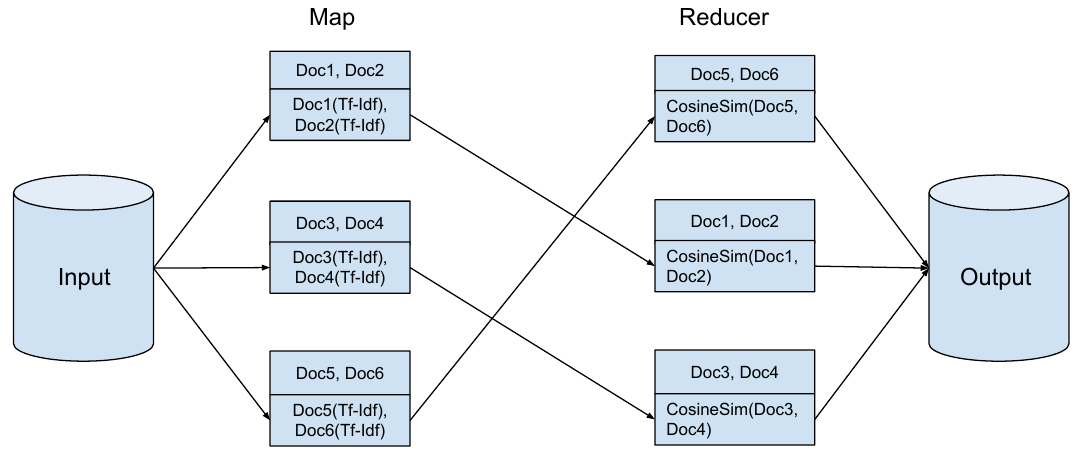
Figure 3. Cosine similarity algorithm